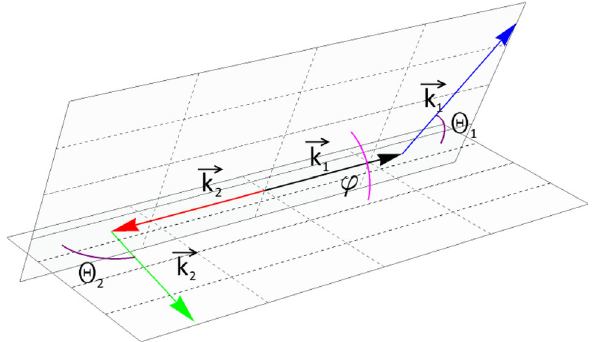
Fig. 7 Definition of the angle ϕ . Each incoming gamma of the back- to-back pair forms with its outgoing photon a so called scattering plane. The relative angle between those two planes is denoted as ϕ